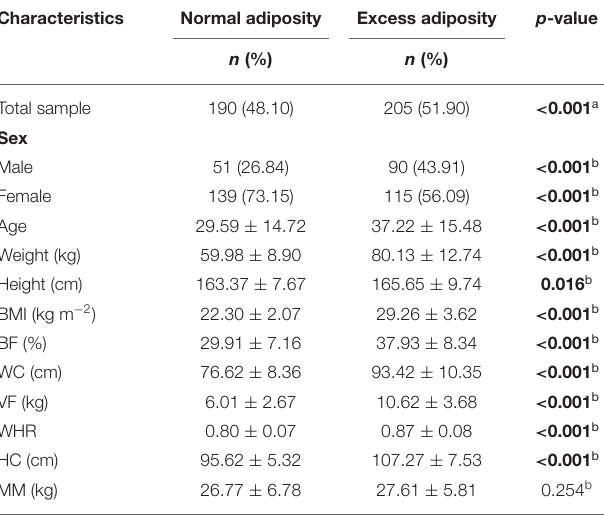
TABLE 5 | Comparative analysis of demographic and body composition characteristics by adiposity groups.